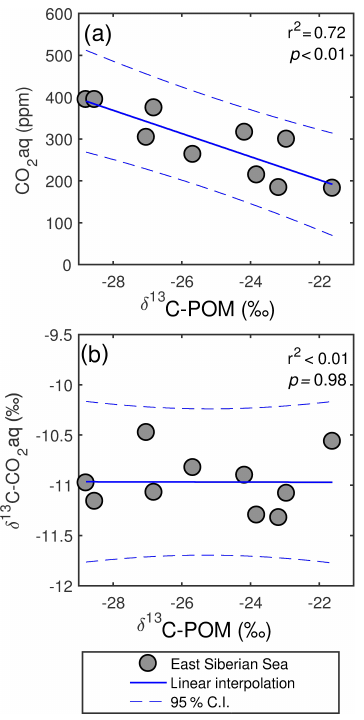
Figure 7. Correlations (a) CO 2 aq versus δ 13 C (POM (>10µm) fraction) and (b) δ 13 C-CO 2 aq versus δ 13 C in the East Siberian Sea (filled circles). The solid line shows the linear interpolation while the dashed line shows the 95% confidence